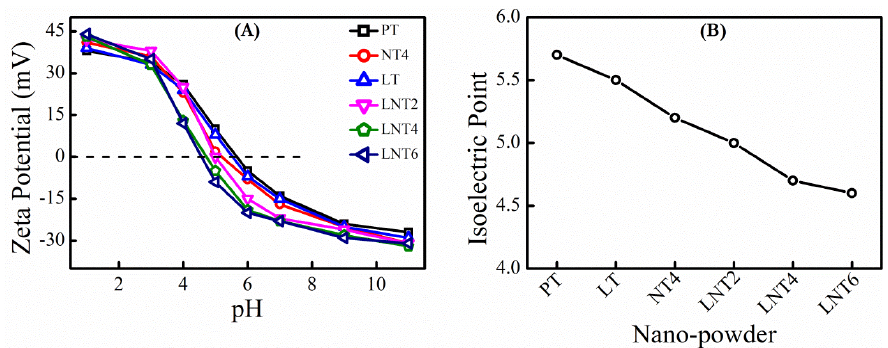
Figure 5. ( A ) Effect of doping in TiO 2 on dispersion zeta potential at different potential. ( B ) The dispersion isoelectronic point (IEP) for different